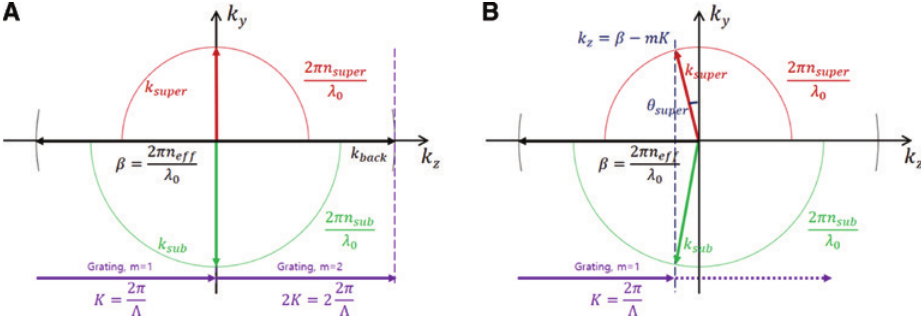
Figure 9: Wavevector representation of the Bragg condition for the grating coupler. (A) Perfectly vertical operation, which generates the second-order diffraction (m = 2) with increased back-reflection. (B) Off-normal operation only generating the first-order diffraction (m = 1) while reducing back-reflection (black arrow: the propagation constant in the waveguide region; purple arrow: the reciprocal lattice vector of the grating; red arrow: the wavevector of the upward-diffracted wave; green arrow: the wavevector of the downward-diffracted